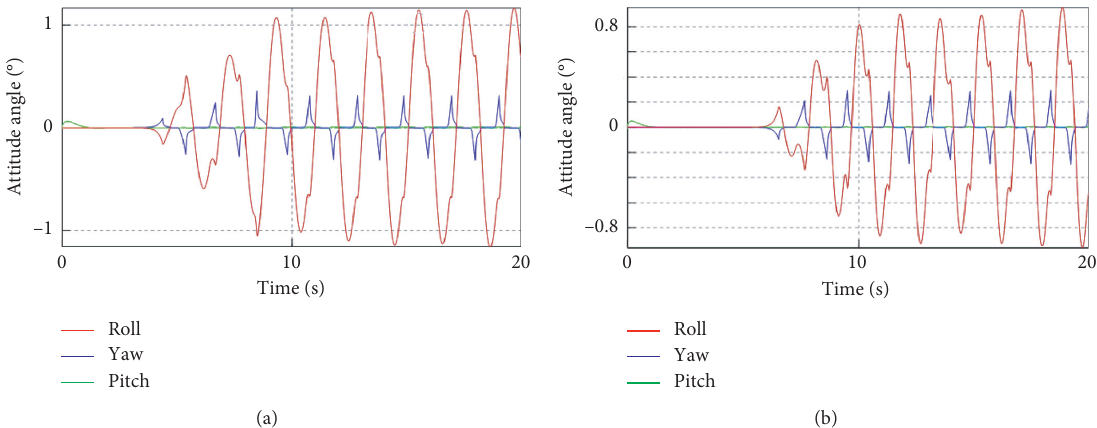
Figure 14: Changes of the attitude angle when the center of mass is (a) 1.5m and (b) 1.1m below the axis of the driving